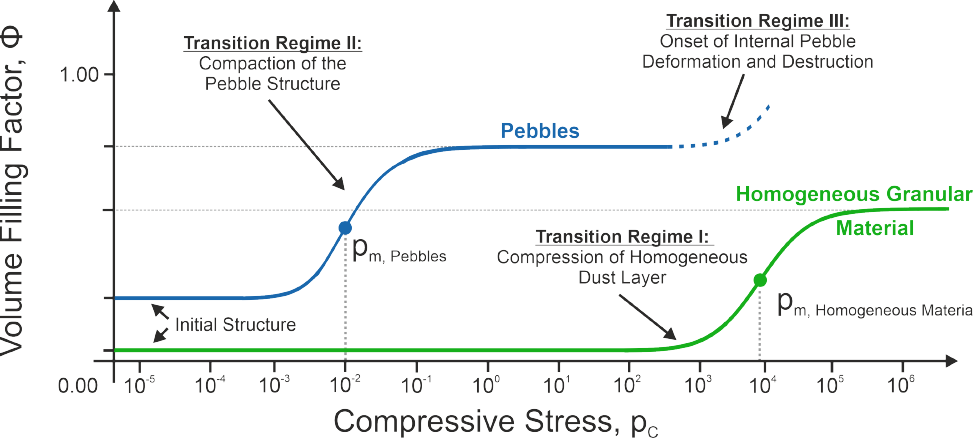
Figure 3. Response function of a granular material to compressive stress. The green curve shows the reaction of a homogeneous, i.e., non-hierarchical, granular material, whereas the blue curve represents the volume-filling factor of a pebble-pile structure, i.e., a hierarchical material. Both functions can be described by S-shaped curves as shown by [216]. The homogeneous material can only be compressed in a single stage (transition regime I), while for the hierarchical material, first the pebble packing will be compressed (transition regime II), then at higher pressures the pebbles will be deformed and destroyed (transition regime III; dashed